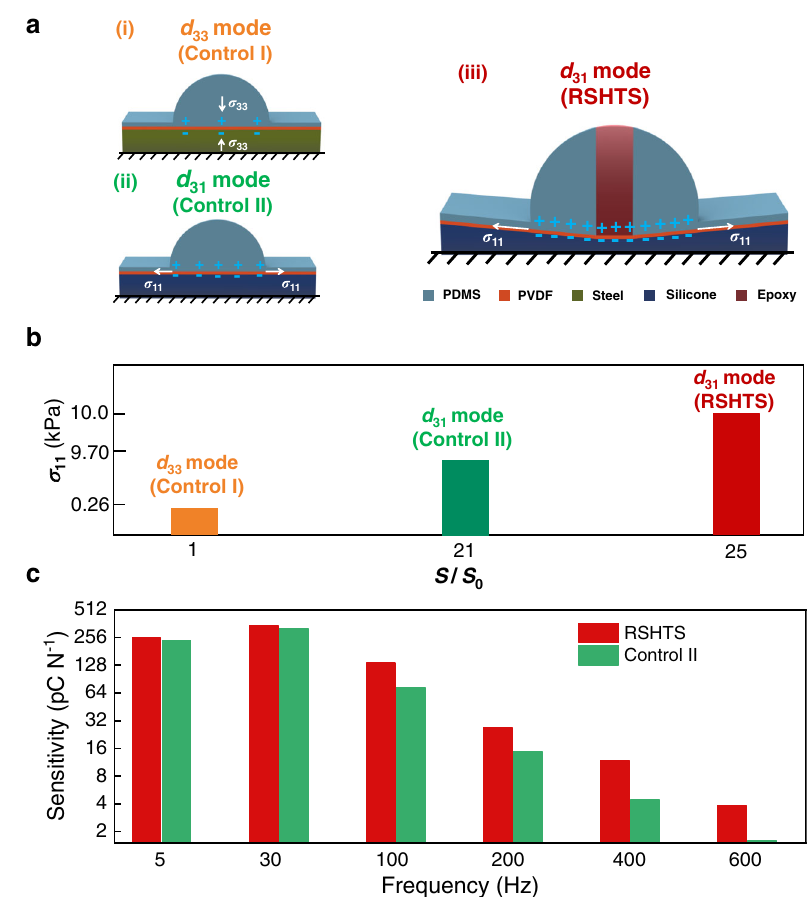
Fig. 2 | Structural design consideration and numerical simulation for stress analysisoftheRSHTS.a Simulationmodelsofcontrolsensorswithrigid(i,Control I) and soft substrates (ii, Control II), and our RSHTS (iii). b Numerical simulation results of control sensors with rigid and soft substrates, and our RSHTS.